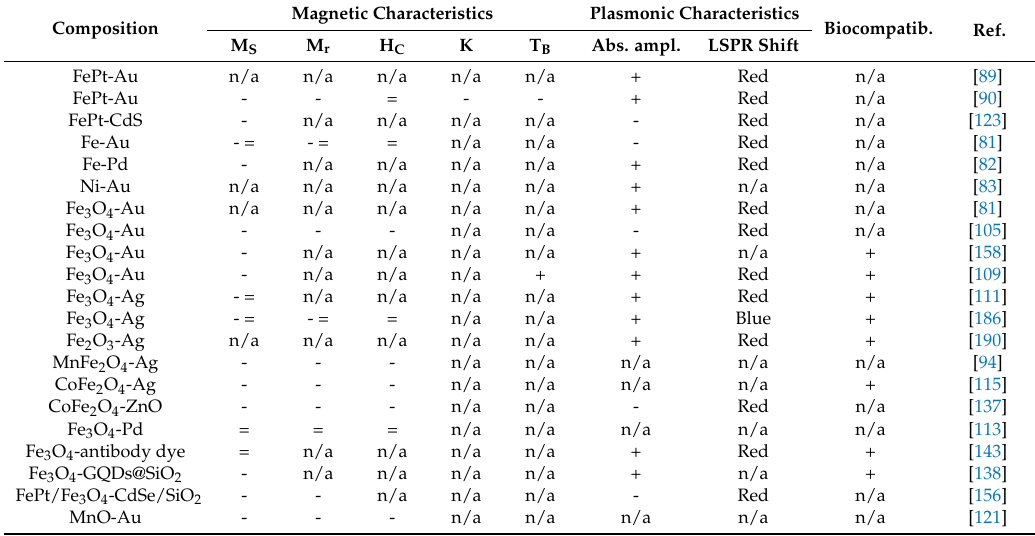
Table 1. Efficacies of different heterodimers on magnetic-plasmonic characteristics like saturation magnetization M S , remanent magnetization M r , magnetic coercivity field H C , effective anisotropy constant K, blocking temperature T B , electro-magnetic absorption amplitude as well as shift of localized surface plasmon resonance (LSPR) peak and